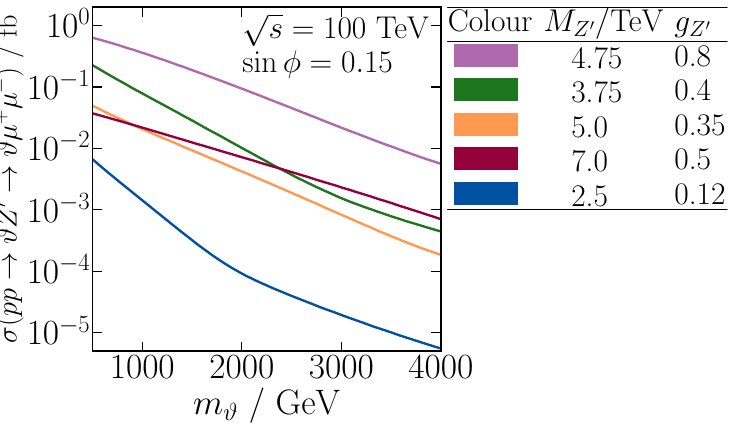
Figure 12. Tree-level flavonstrahlung cross-sections for 100 TeV pp collisions for q θ = 1 . Each coloured line corresponds to a parameter space point labelled by a star of the same colour in figure